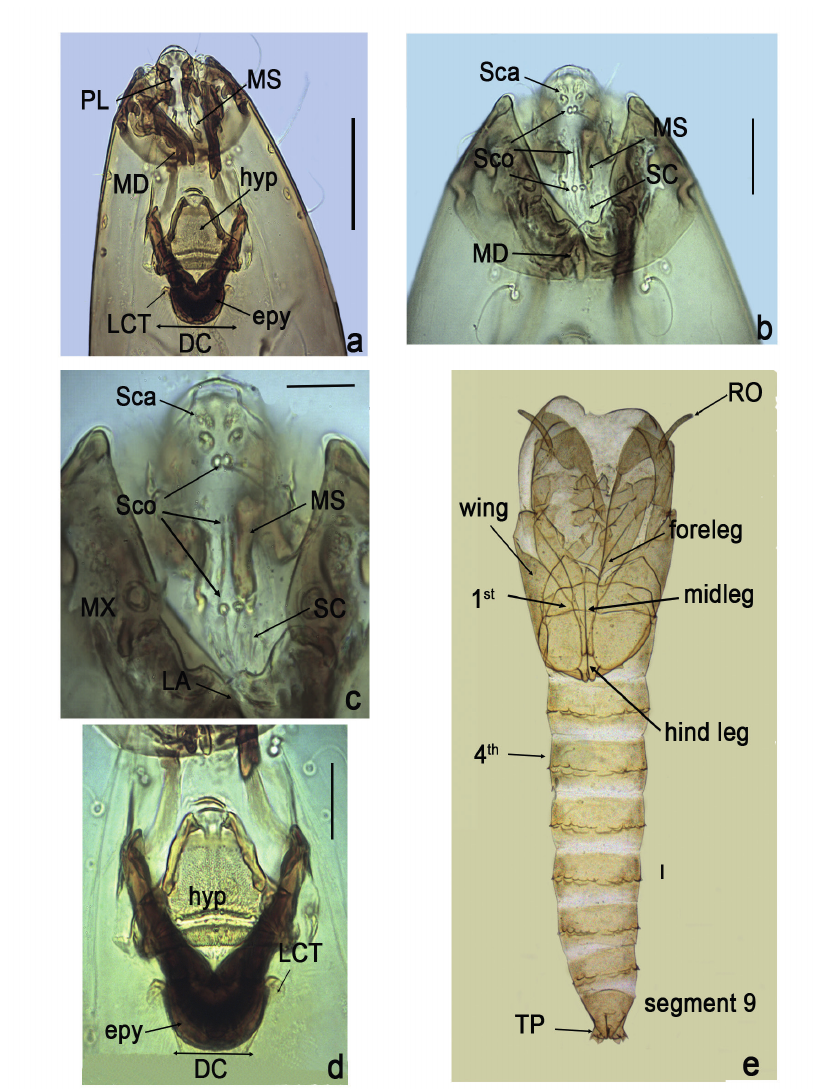
Figure 3 - Dasyhelea flavifrons Guérin-Méneville, a-d ) larva, e ) male pupa; a ) head capsule ( ventral view); b ) head capsule (frontal view); c ) detail of palatum; d ) epipharynx and hypopharynx; e ) entire pupa. Dorsal comb (DC); epypharynx (epy); hypopharynx (hyp); labium (LA); lateral curtains (LTC); mandible (MD); maxilla (MX); messors (MS); palatum (PL); respiratory organ (RO); sensilla campaniformia (Sca); sensilla coeloconica (Sco), scopae (SC); terminal processes